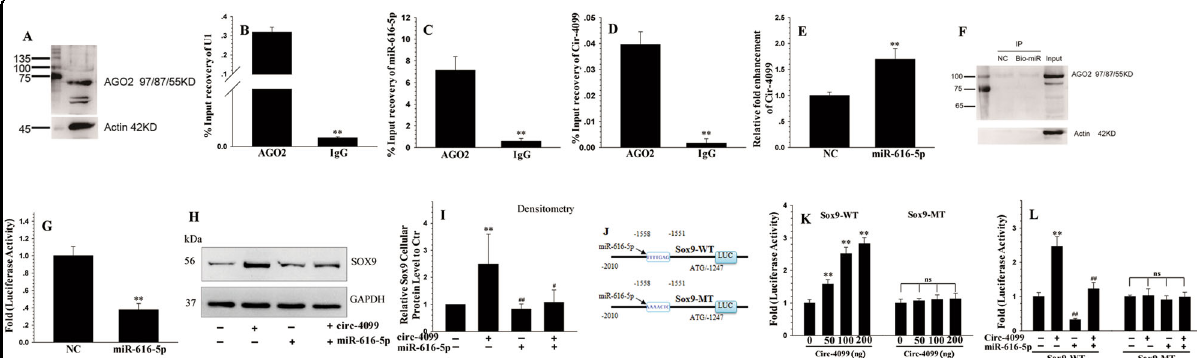
Fig. 4 Circ-4099 and miR-616-5p binding by RIP and RNA – RNA pull-down assays. a The expression of AGO2 protein can be detected by WB in hNP cells. b RIP assay showed that AGO2 was associated with U1, which acts as a positive control. c , d RIP assay showed that the anti-Ago2 antibody ef fi ciently captured miR-616-5p transcripts; circ-4099 was also detected in these RNA – protein complexes, which shows that it may bind to miR-616- 5p transcripts and be indirectly captured by anti-Ago2. e RNA – RNA pull-down qRT-PCR showed an approximately twofold enrichment of circ-4099 in the miR-616-5p-captured fraction compared with the negative control. f WB showed signi fi cantly higher AGO2 protein in the miR-616-5p-captured fraction compared with the negative control. g miR-616-5p mimic treatment caused decreased luciferase activity with the LUC-circ-4099 plasmid. h Western blot and i corresponding densitometry analyses showed that Sox9 mRNA expression can be upregulated by circ-4099 over-expression, which can be suppressed by treatment with miR-616-5p mimics. j schematic of constructs Sox9-WT and Sox9-WT containing mutation in miR-616-5p sites generated by site-directed mutagenesis. k Co-transfection with circ-4099 results in a dose-dependent increase in Sox9-WT activity, but no signi fi cant induction at the Sox9-MT promoter. l miR-616-5p mimics blocked the inductive effects of circ-4099 on the wild-type Sox9-WT promoter, while no signi fi cant responses was observed with the Sox9-MT